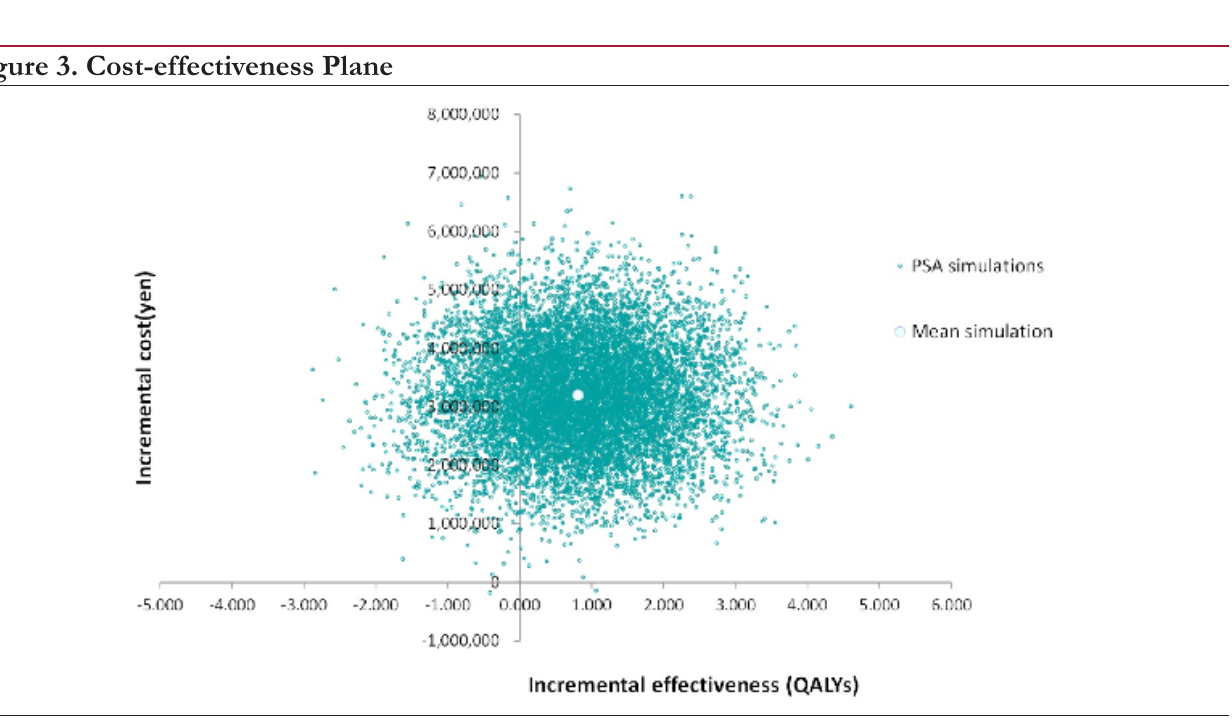
QALYs: quality-adjusted life years; ICER: incremental cost-effectiveness